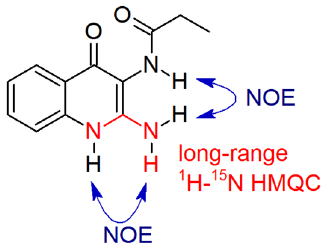
Figure 3. NOE and long-range 1 H- 15 N-HMQC correlations that confirmed acylation in position 3.